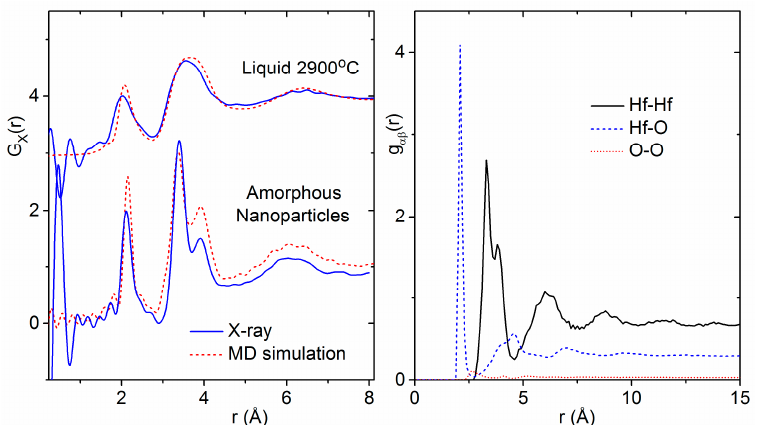
Figure 9. ( Left ) X-ray pair distribution functions of liquid HfO 2 compared to the ab initio simulations performed in this study (shifted top, see text) and amorphous hafnia nanoparticles compared to the classical MD simulations performed in this study based on the parameters given by Broglia et al. [1]. ( Right ) The partial pair distribution functions for the amorphous nanoparticle simulation weighted by the Q = 0 factors for the X-ray case given in Equation (1).